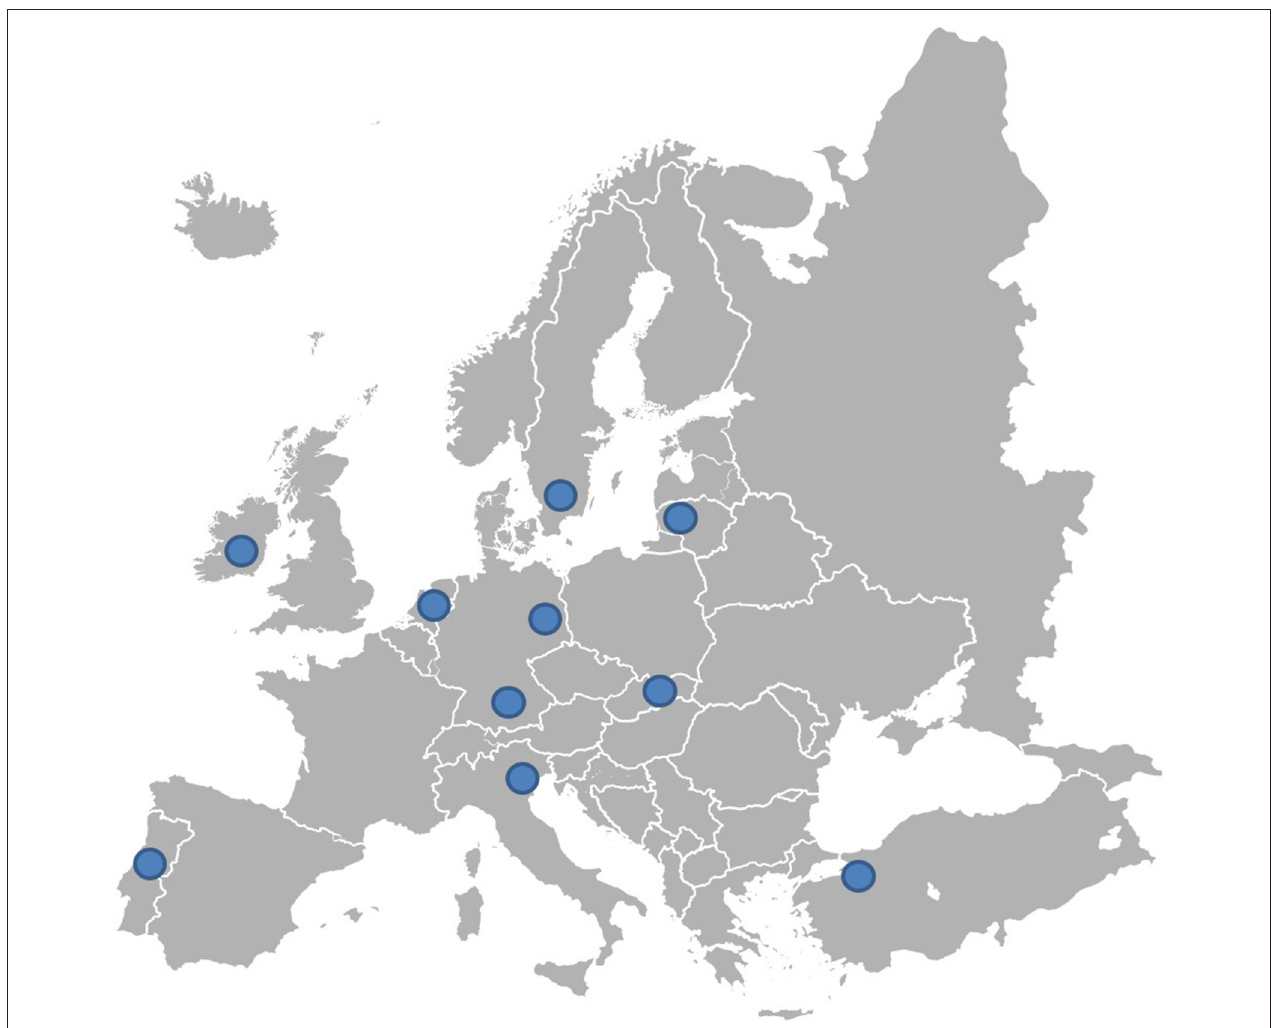
FIGURE 1 | Locations of the case study landscapes.